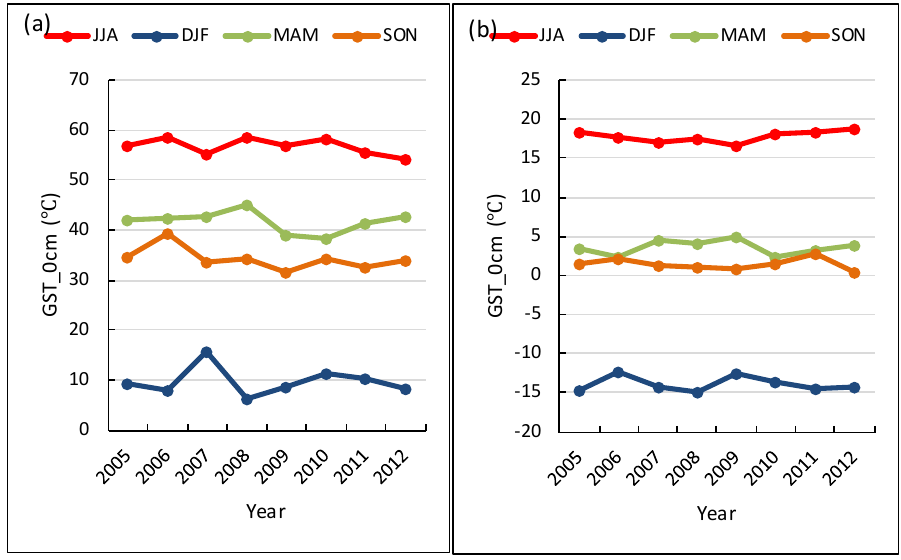
Figure 7. Inter-annual mean GST ( ◦ C) for the period 2005–2012: ( a ) at daytime; ( b ) at